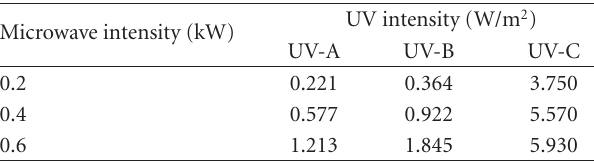
Table 1: Comparing the UV intensities radiated at di ff erent micro- wave